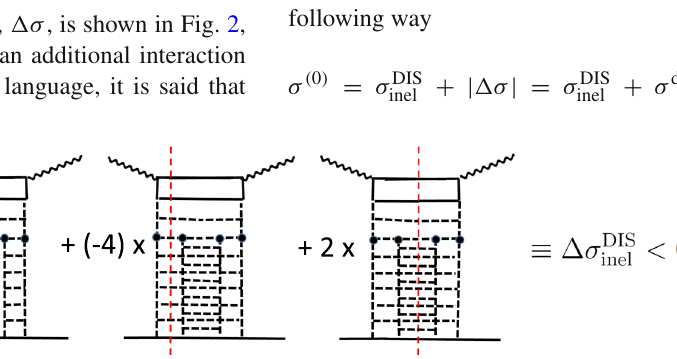
the weights of the three diagrams are 1 , − 4 , 2 respectively. The neg- ative weight of the central diagram, with only one ladder cut, follows since it describes the absorptive correction due to the rescattering of an intermediate